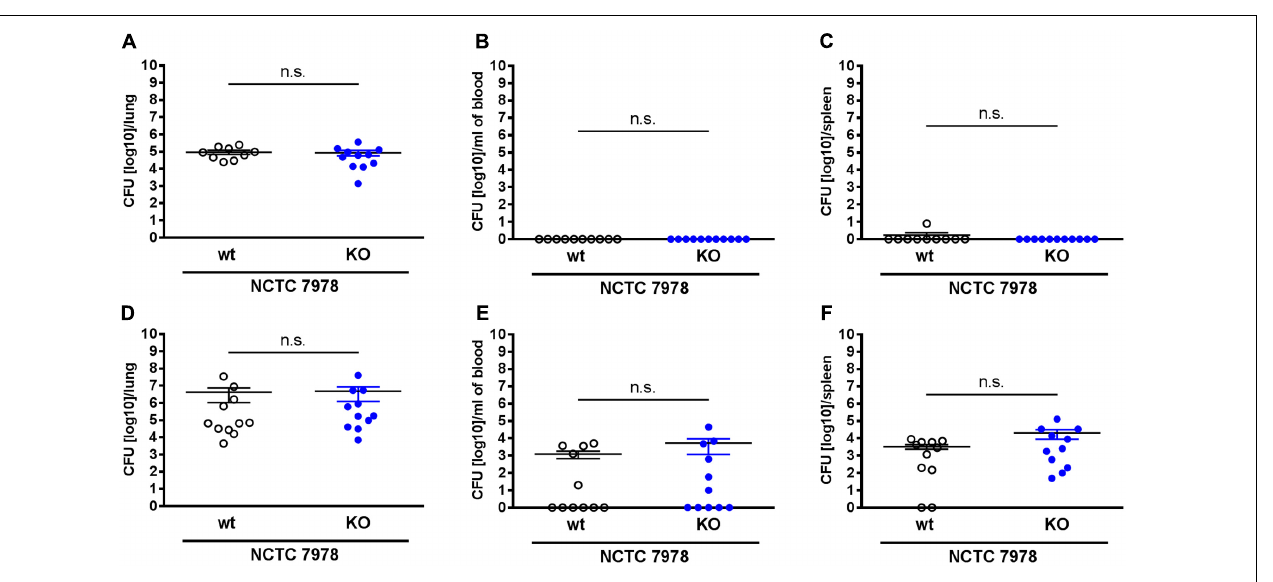
CD4 + , CD8 + , and B cells. No differences were seen in AMs ( Figure 4G ) and γδ -T cells ( Figure 4I ). PGLYRP3KO